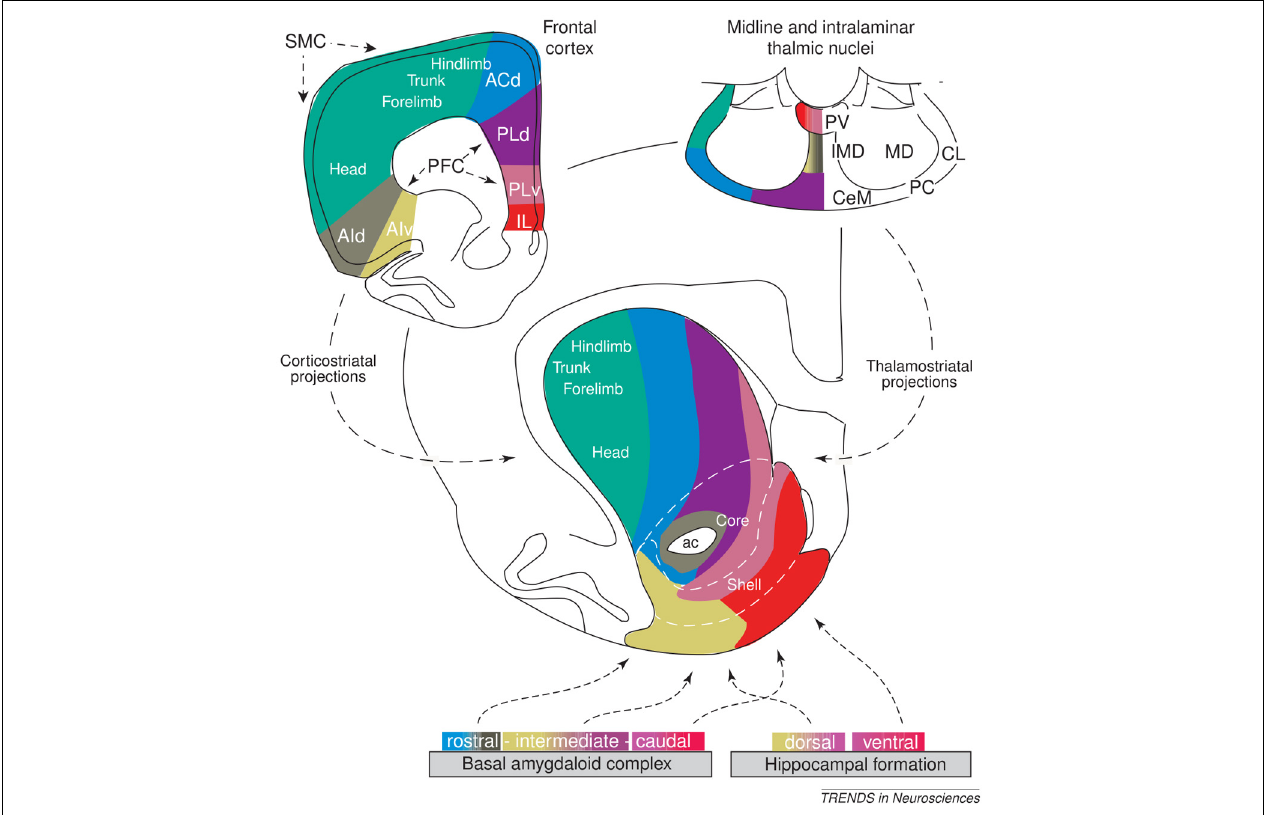
FIGURE 14 | Anatomy and connections of nucleus accumbens, basolateral amygdala, hippocampus, and prefrontal cortex. Reprinted from Voorn et al. (2004), Copyright 2004, with permission from Elsevier.